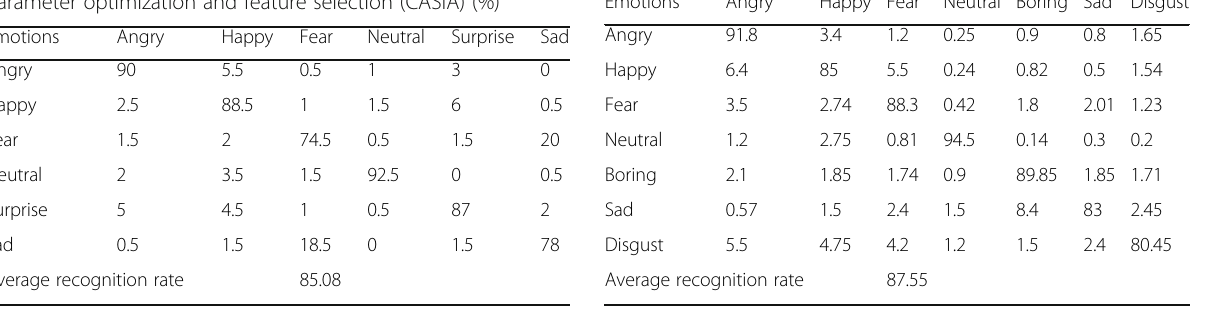
Table 15 Emotion recognition rates of decision tree SVM with parameter optimization and feature selection (EMO-DB) (%) Emotions